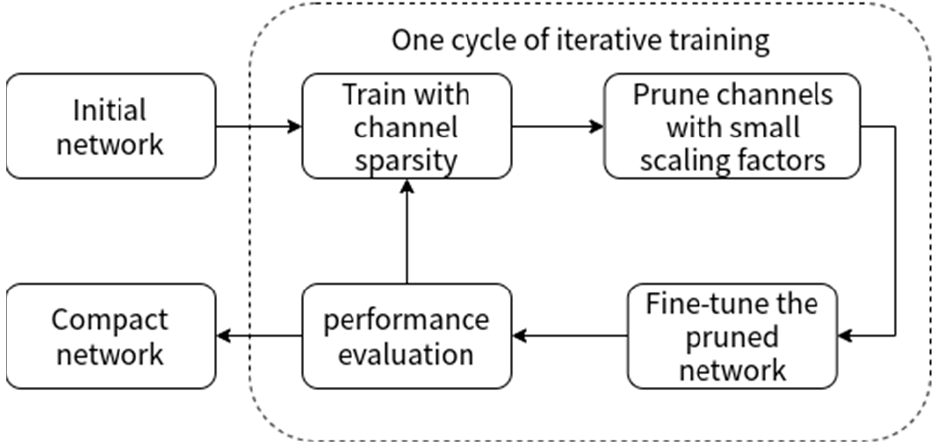
Figure 2. Model compression process.